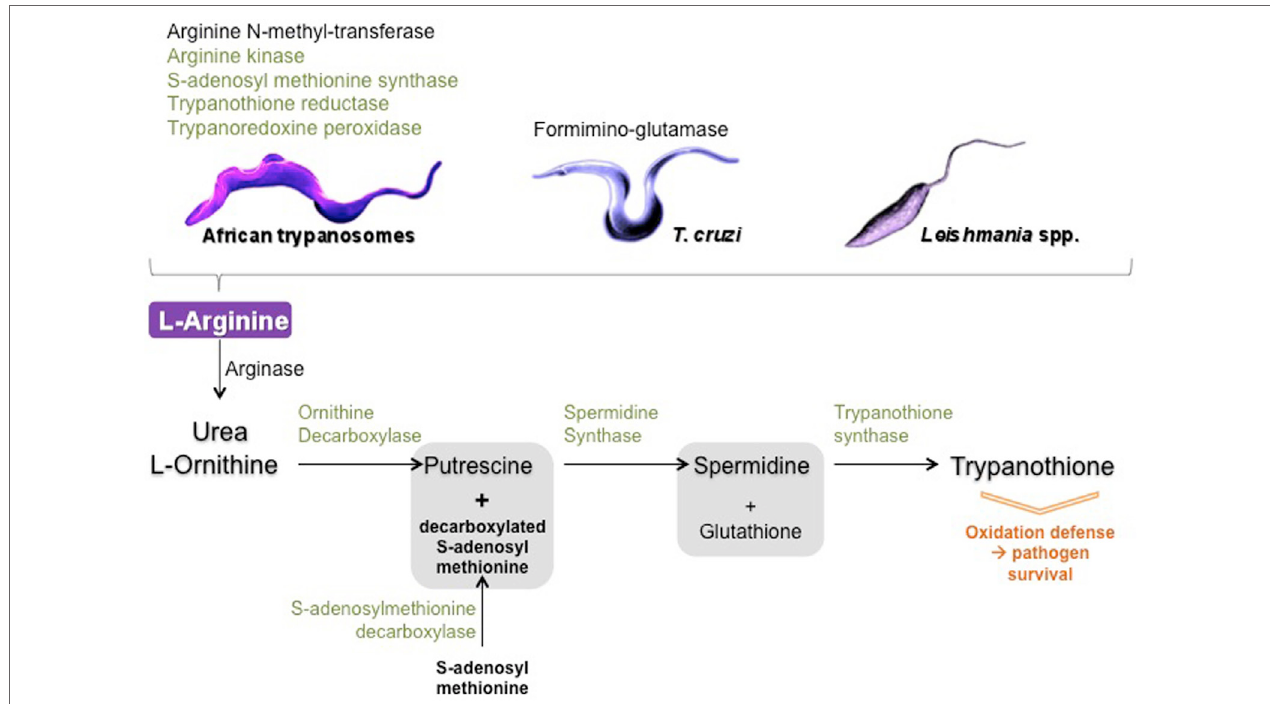
FiGURe 4 | Schematic view of trypanosomatid arginase and arginine metabolism enzymes. In black: enzymes only identified in the proteome of trypanosomatids and in green: enzymes identified in the secretome of